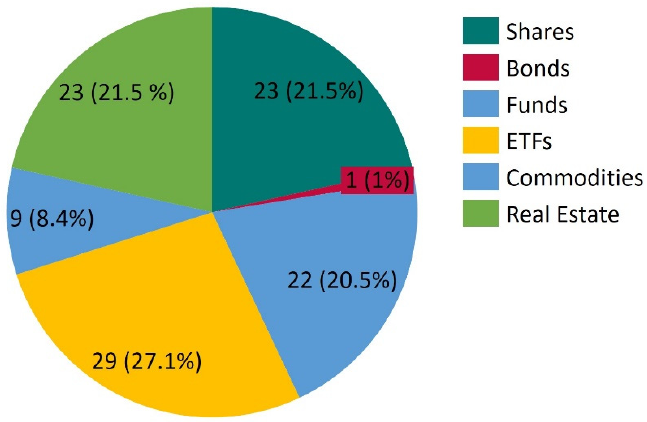
Figure 1. The initial asset composition for the lower-risk portfolio.